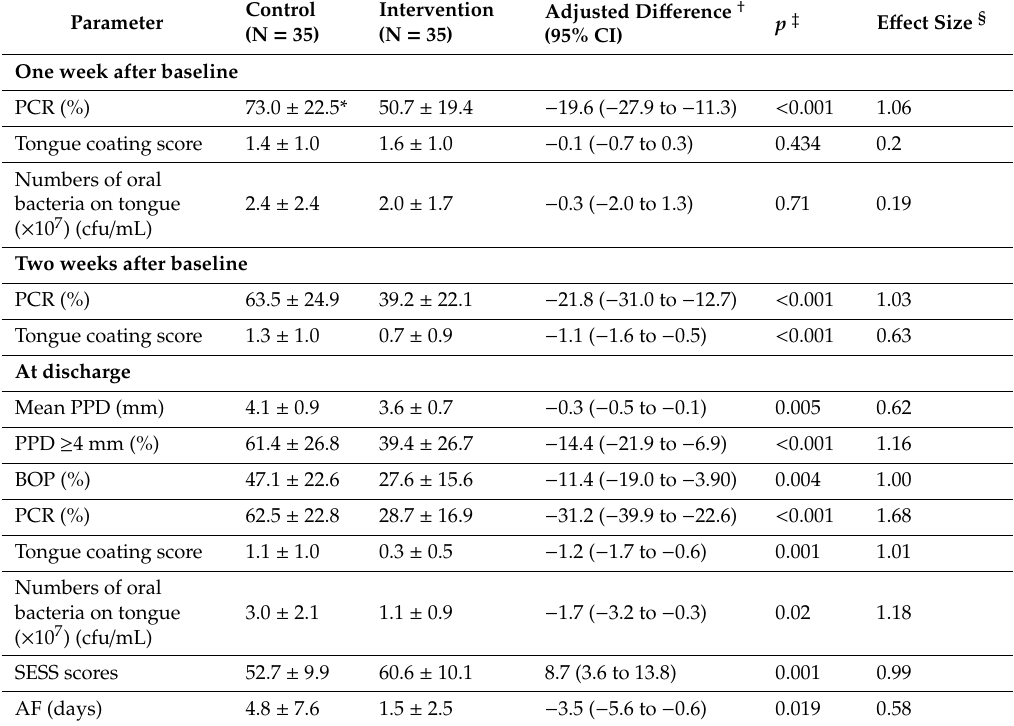
Table 4. Di ff erences in oral status, self-e ffi cacy scale for self-care and atrial fibrillation between control and intervention